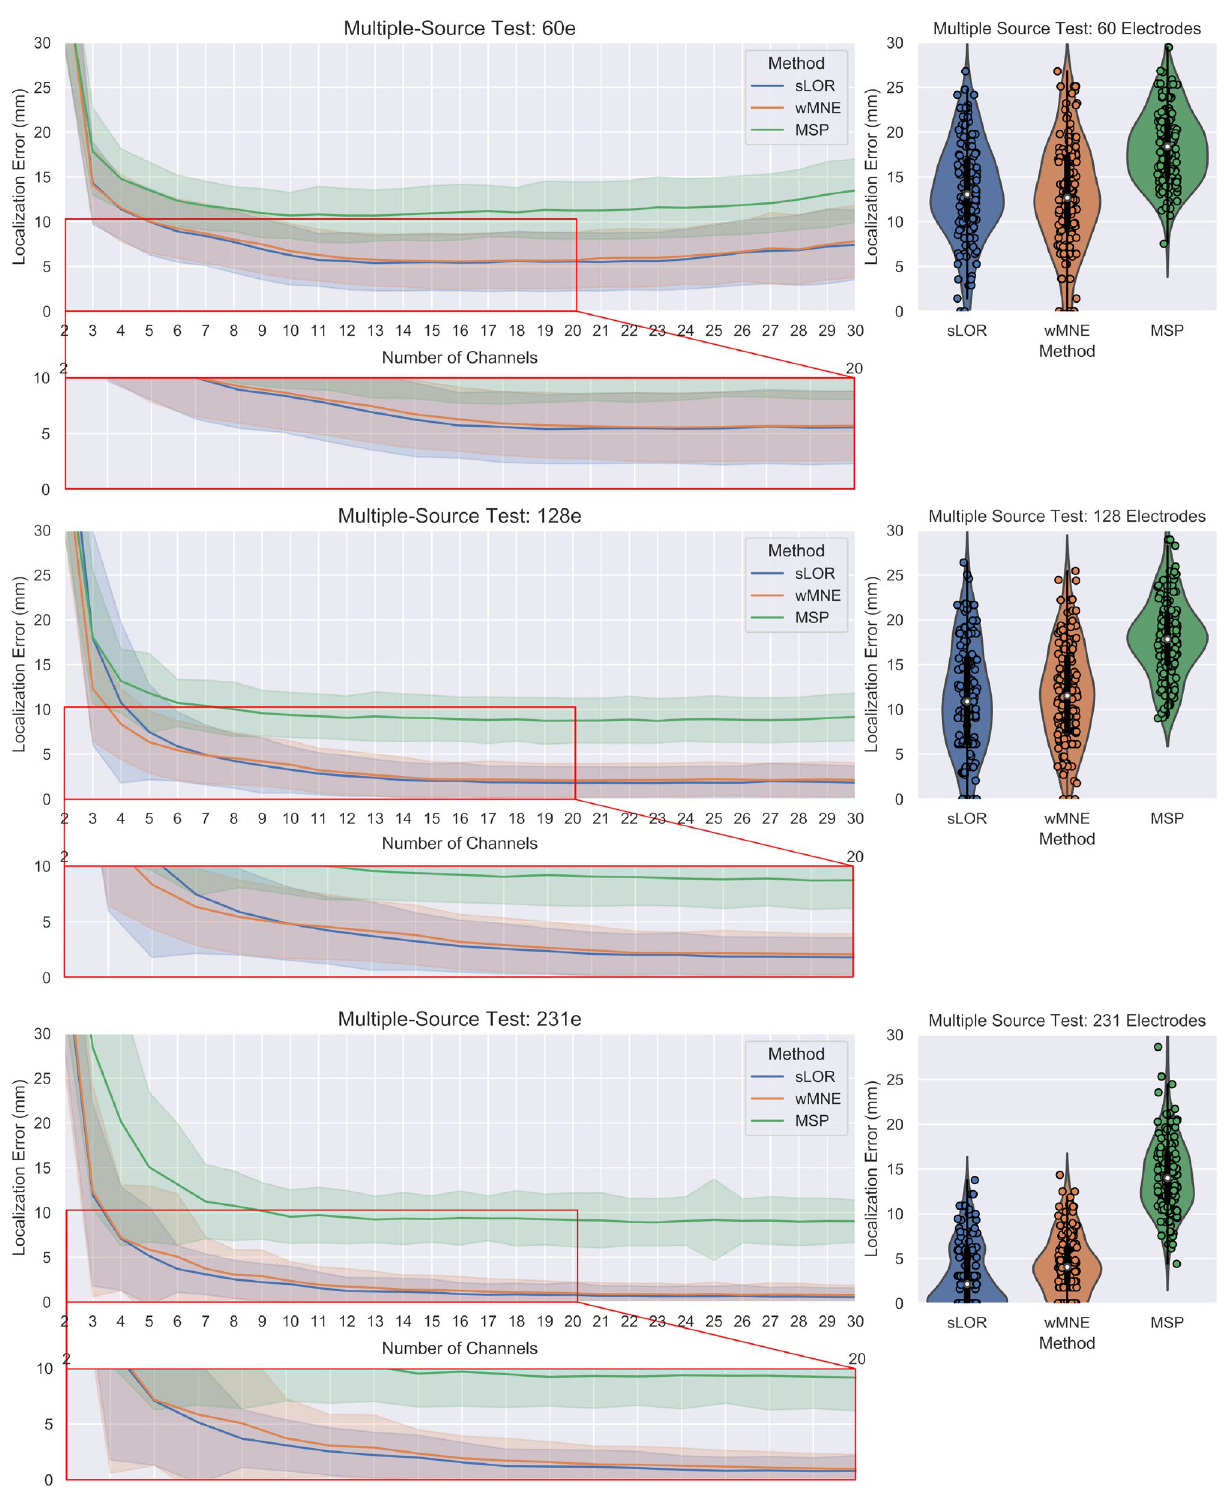
Figure 7. The pseudo-Pareto fronts for the multiple-source test with the different constrained number of channels are shown at left. They relate to the number of channels vs the average between the three sources’ localization error. The lines represent the mean of the localization error ∗ of the three sources across the 150 trials, and the colored bands the standard deviation. The mean localization error ∗ across the trials and the standard deviation obtained by using the subsets of 60 and 128 electrodes, and the full set of 231 electrodes for the three sources, are presented at right. ∗ The mean localization error is computed using the average error between the three sources and then the average of this value across the 150